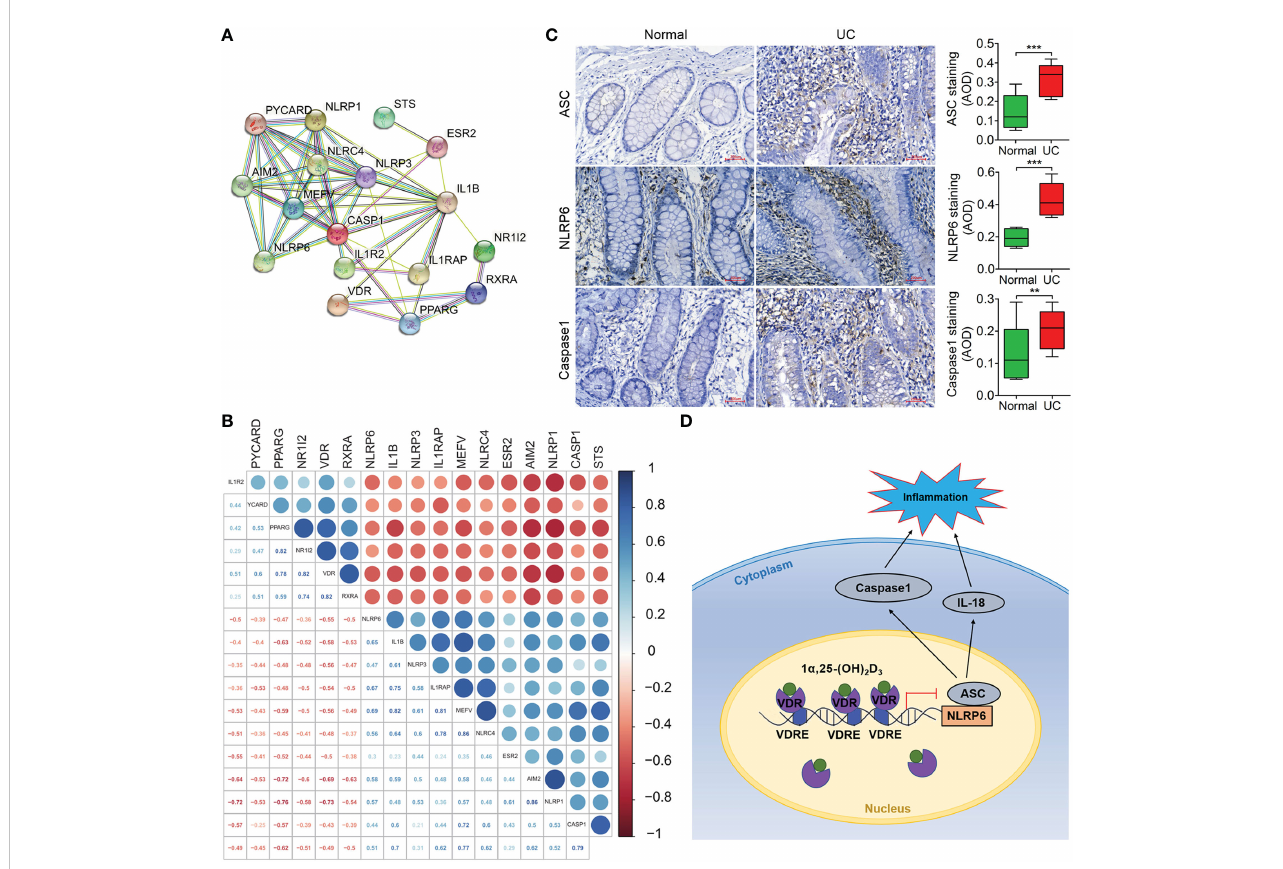
FIGURE 7 VDR expression is negatively correlated with NLRP6 expression and has the potential to be used for clinical prognosis prediction. (A) Protein – protein association network of the NLRP6-(Caspase-1)/IL-1 b signalling pathway in STRING. VDR, NLRP6, ASC and Caspase-1 were selected as input. (B) Correlation of gene expression was analysed in GSE128682 ChiP data. The correlation coef fi cient ranges from − 1 (red colour) to +1 (blue colour). The red region represents absolute negative correlations, afnd the blue region represents absolute positive correlations. Hclust, hierarchical clustering order. A value of 0.05 was chosen as the signi fi cance level. (C) Immunohistochemical analysis of ASC, NLRP6 and Caspase-1 expression in normal and UC tissue samples from representative patients. (D) Schematic illustration of VDR-NLRP6 signalling in MIECs. There are three VDREs in the promoter region of NLRP6. The transcription factor VDR transcriptionally represses NLRP6 by binding to the VDRE, reducing NLRP6 expression. The data are shown as the mean ± SD, n ≥ 3, * P < 0.05 ; ** P < 0.01 , *** P <